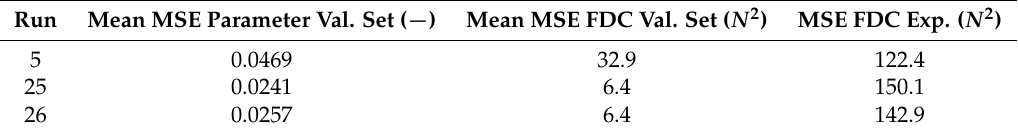
Table 3. Reduced settings and results of NN-based material parameter identification Runs